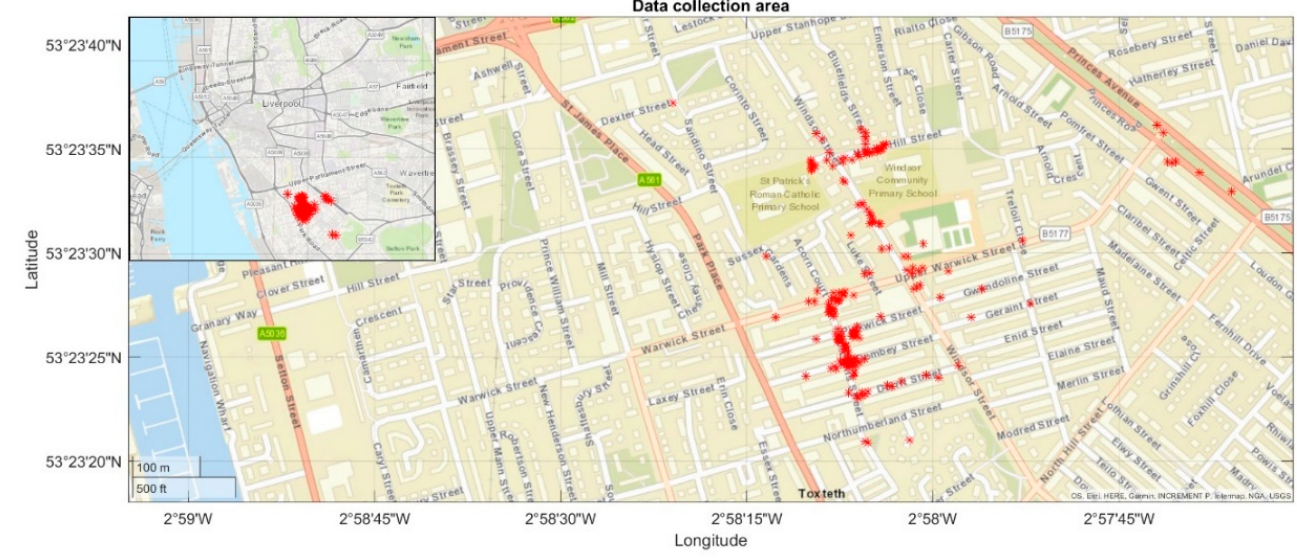
Figure 2. Location of data